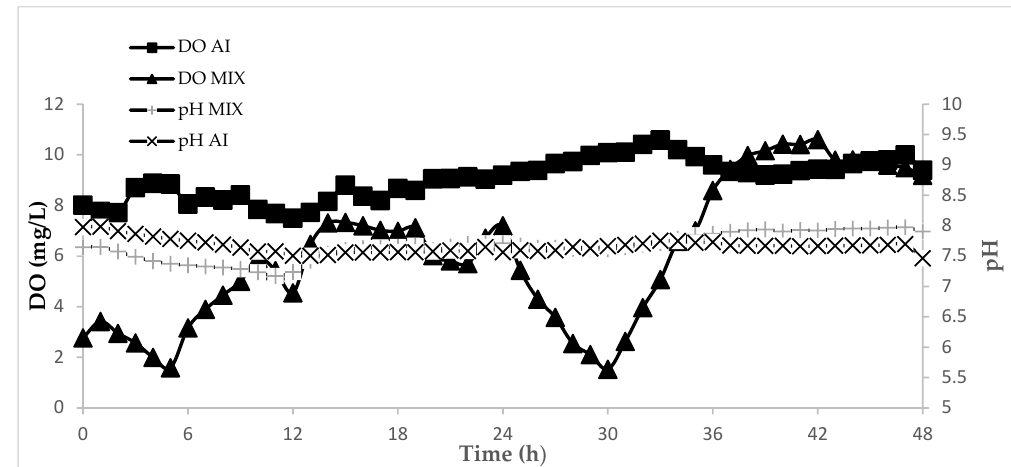
Figure 3. Dissolved oxygen profile for AI (air mixing)/MIX (mechanical mixing) for 48 h throughout D/L photoperiod with feeding at dark phase.